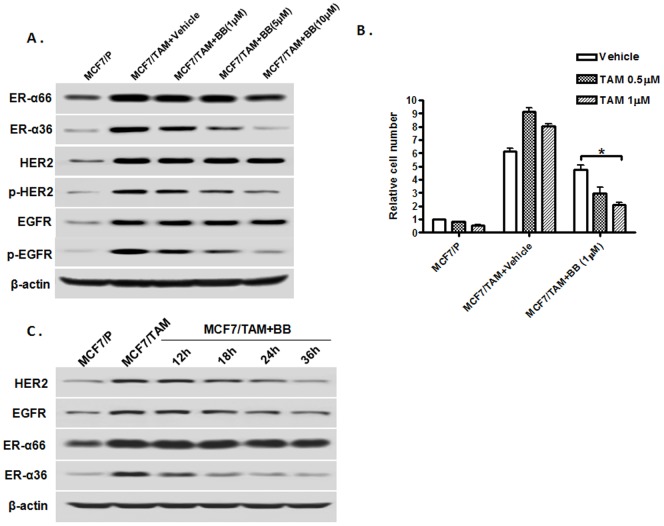
ER-α36 disruptor Broussoflavonol B restores TAM sensitivity.A. Western blot analysis of the expression of ER-α36, ER-α66, EGFR and HER2, and levels of EGFR and HER2 phosphorylation in parental MCF7 (MCF7/P) and MCF7/TAM cells treated with indicated concentrations of Broussoflavonol B (BB) for 12 hours. B. Cells were treated with indicated concentrations of tamoxifen (TAM) together with vehicle or 1 µM of Broussoflavonol B (BB) for seven days and the numbers of survived cells were counted. The columns represent the means of three experiments; bars, SE. *, P<0.05 for MCF/TAM cells treated with vehicle vs cells treated with 1 µM of tamoxifen and BB.